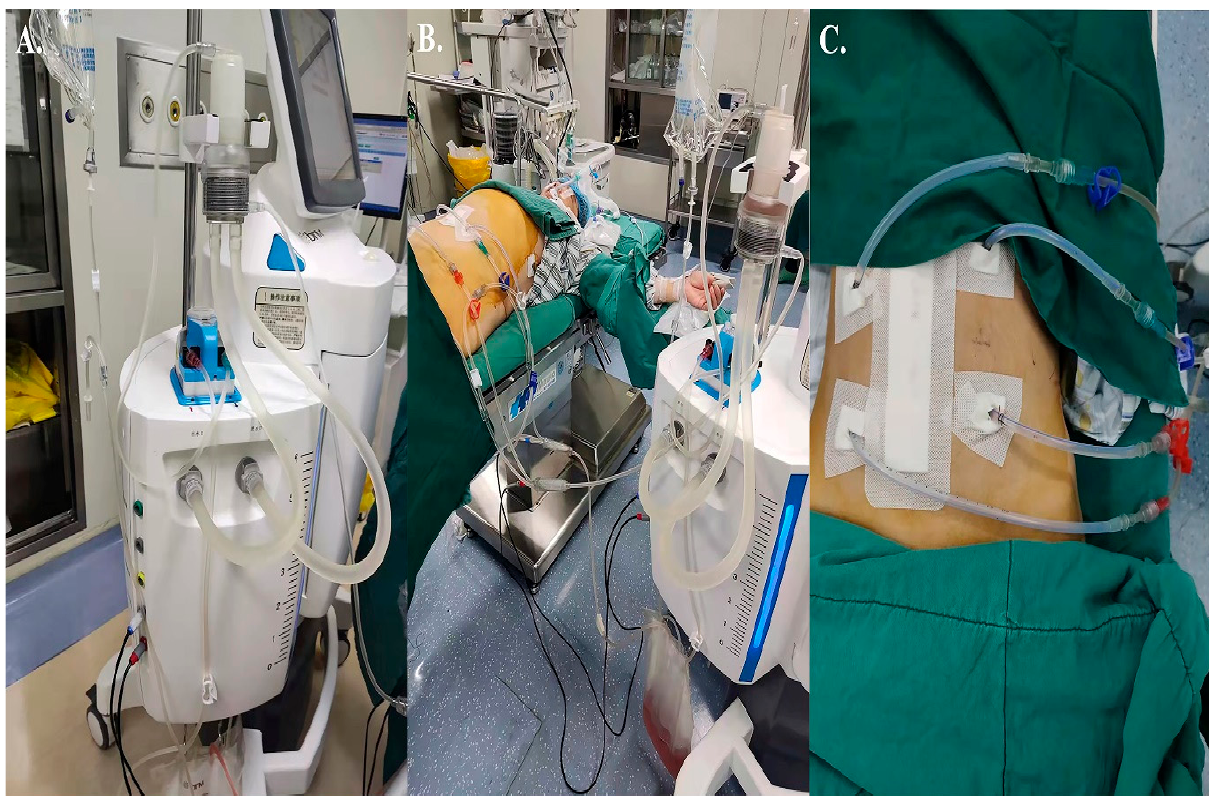
Figure 1. Perfusion equipment and pipe connection. ( A ) The BRTRG-I hyperthermic perfusion intraperitoneal treatment system (Bright Medical Tech, Guangzhou, China). ( B ) Pipe connection. The red tube is the inlet tube, and the blue tube is the outlet tube. The perfusion fluid enters the abdominal cavity from the red tube below and flows out through the blue tube above. ( C ) Four tubes were used for circulatory perfusion; two each were placed in the upper and lower abdomen. Table 1. Baseline clinicopathological characteristics of patients with T4 colorectal cancer before